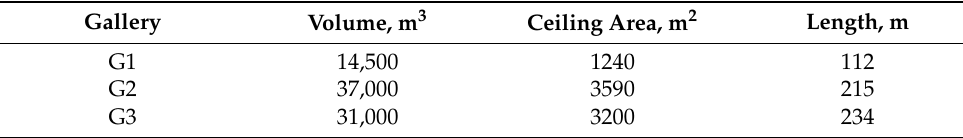
Figure 2. Floor plans and sections of the studied galleries. Table 2. Geometrical characteristics of the